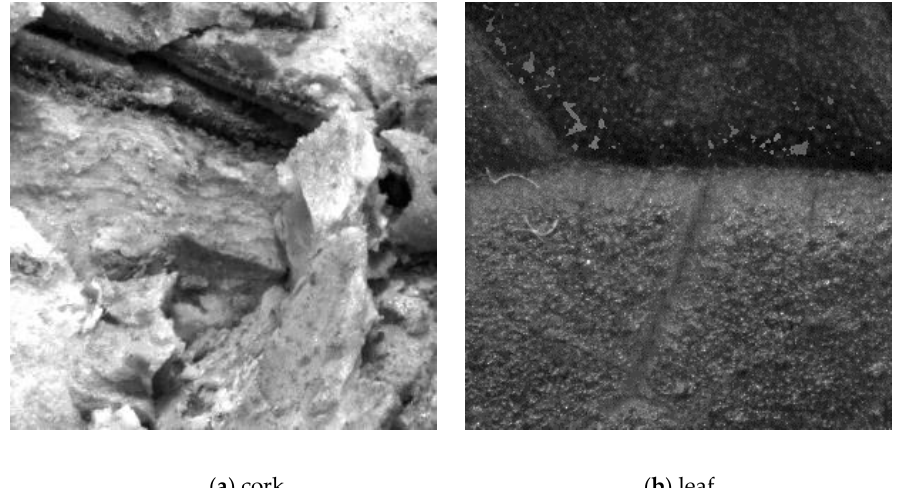
Figure 10. Real objects for qualitative tests. ( a ) A broken cork, ( b ) a leaf.